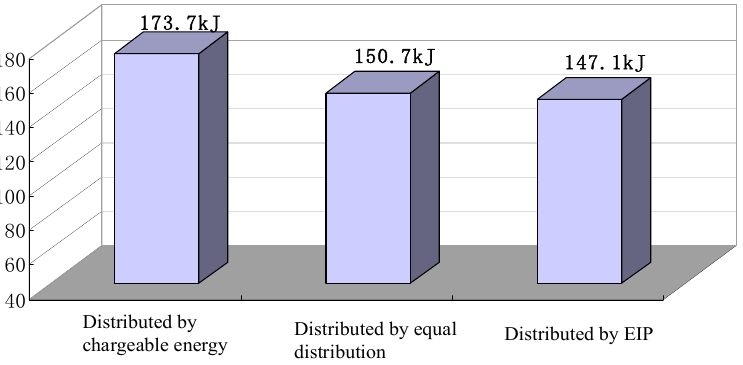
Figure 18. Comparison of the total charging loss.